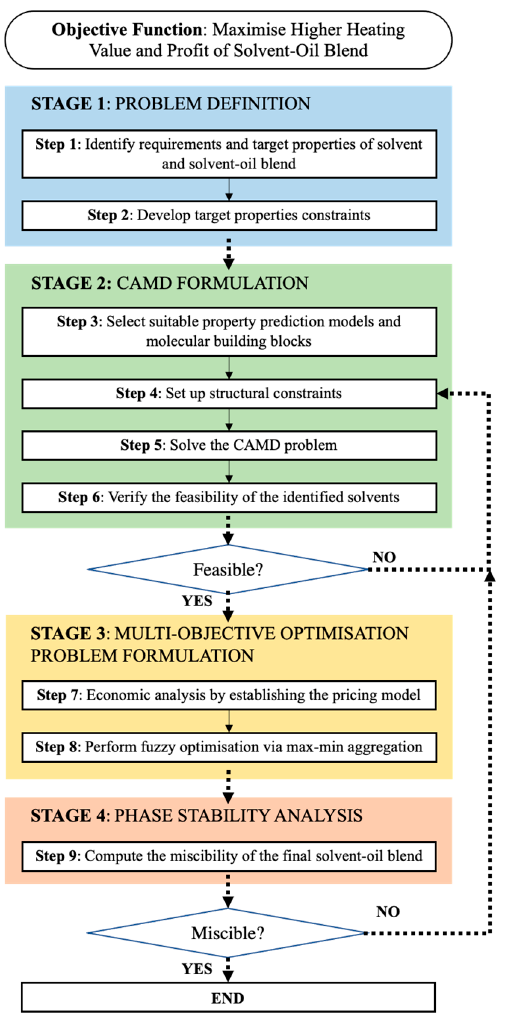
Figure 1. Graphical summary of the work carried out in this research.